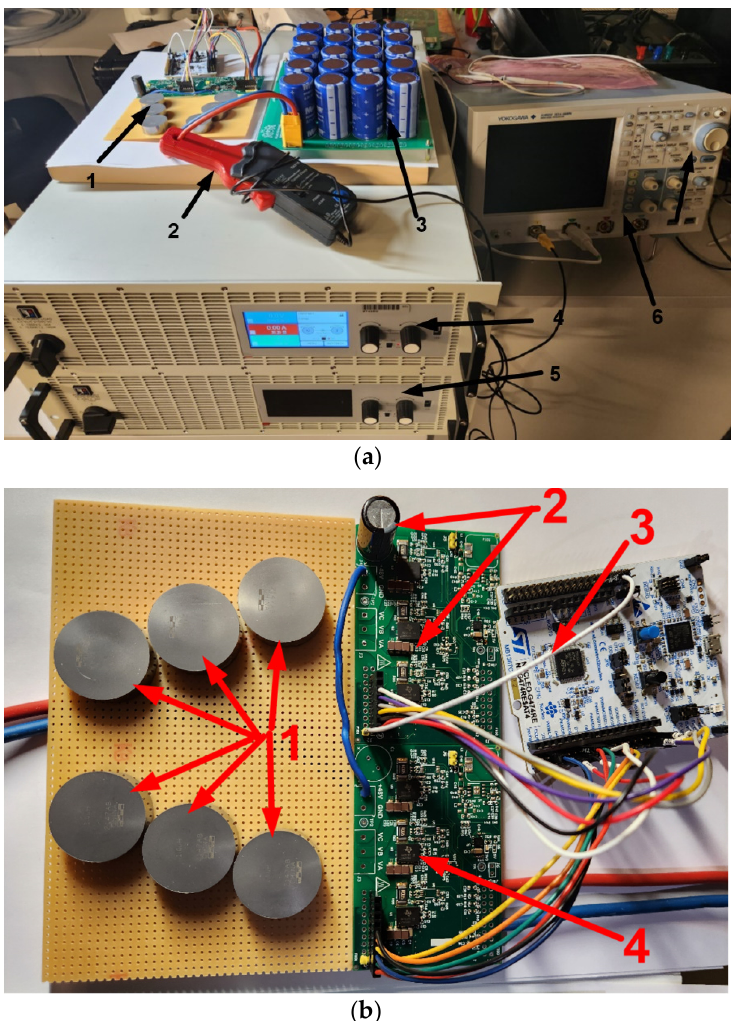
Figure 33. ( a ) Experimental setup used for verification of theoretical results: 1—DC–DC converter,